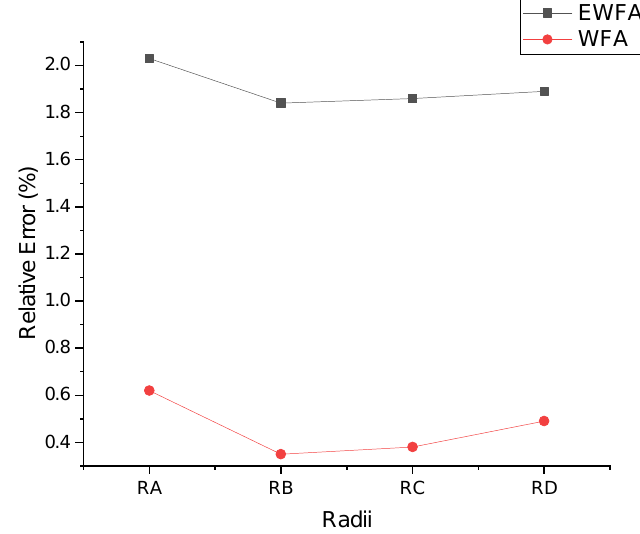
Figure 10. The error of radii in the second